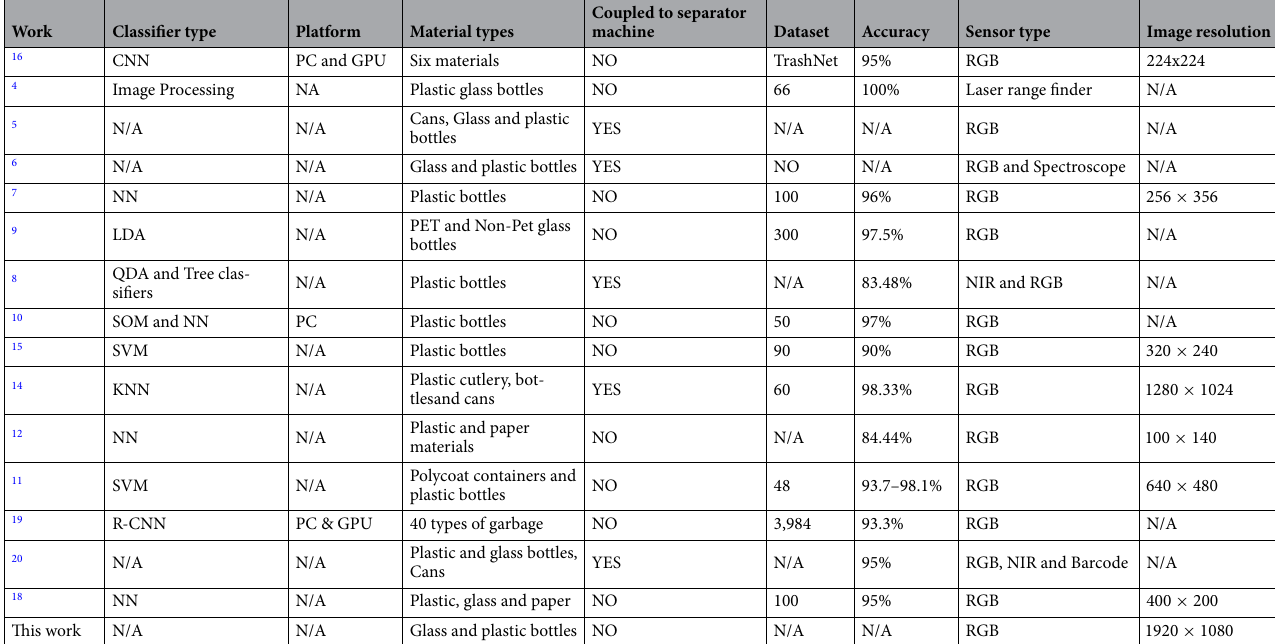
Table 3. Comparison of proposed system with systems reported in the